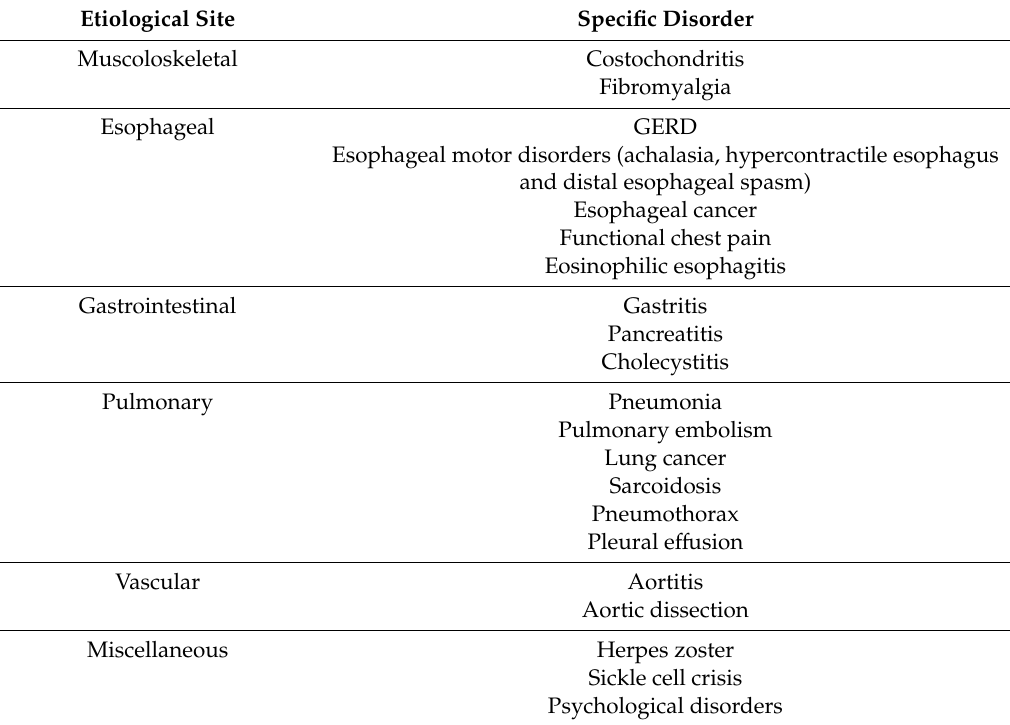
Table 1. Non-Cardiac Chest Pain Etiologies. GERD: gastroesophageal reflux